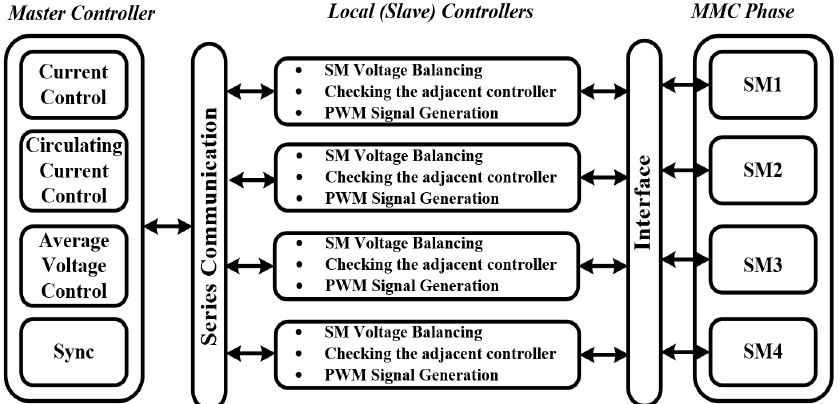
Figure 2. An illustration of the modular distributed fault-tolerant controller.